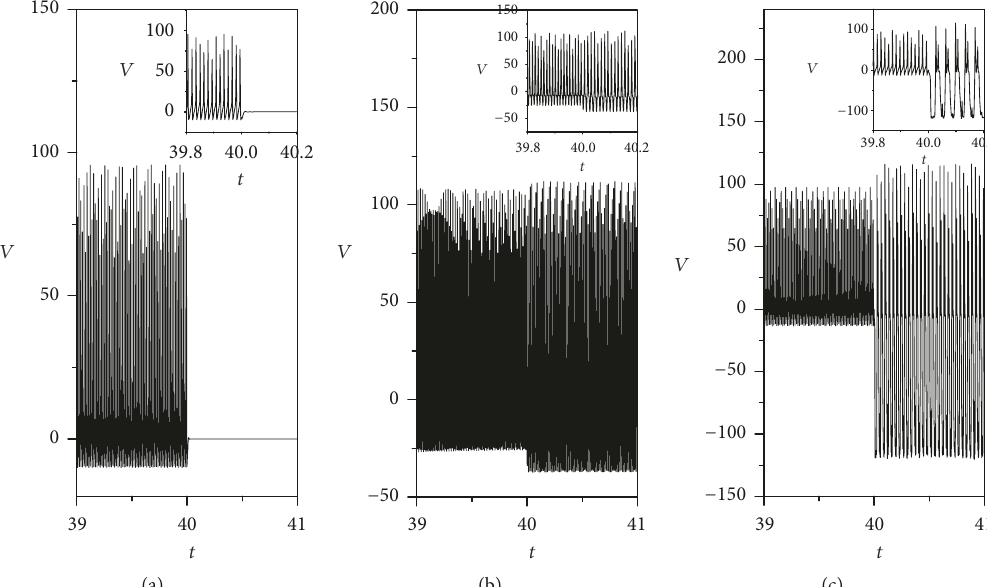
Figure 11: Sampled time series for membrane potential of neuron coupled by astrocypte when autapse driving is considered different time delays at 𝑔 𝑒 = −0.5 , for (a) 𝜏 = 0.1 , (b) 𝜏 = 6 , and (c) 𝜏 = 15 . The parameter is set as 𝑟 IP external forcing current regulates the neuron by setting 𝐼 ext = 10.0 𝜇 mol/L ⋅ cm 2 at 𝑡 < 40 s. The inserted figure is enlarged to show the sampled time series for membrane potential from 𝑡 = 39.8 to 40.2 ms.